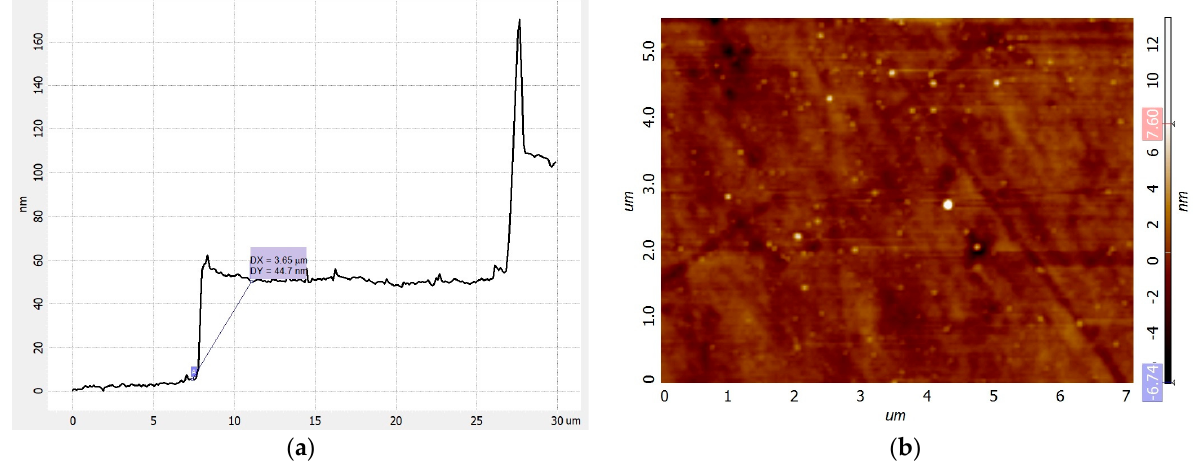
Figure 11. ( a ) AFM cross-section image for 32-level spiral axicon m = 4 in fused silica, 44.7 nm step, ( b ) roughness 2D profile—0.8 nm for 7 μ m 2 area.